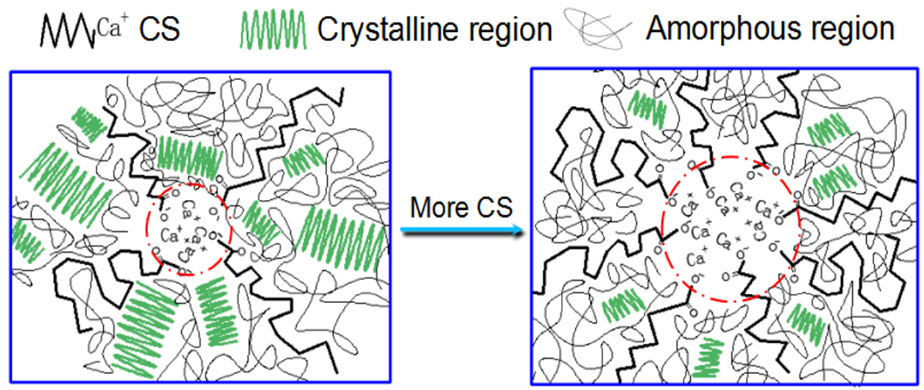
Figure 7. Schematic representation of the effect of CS addition to UHMWPE. This figure highlights the possible ways in which the increase in the size of calcium ionic clusters reduces their strength.